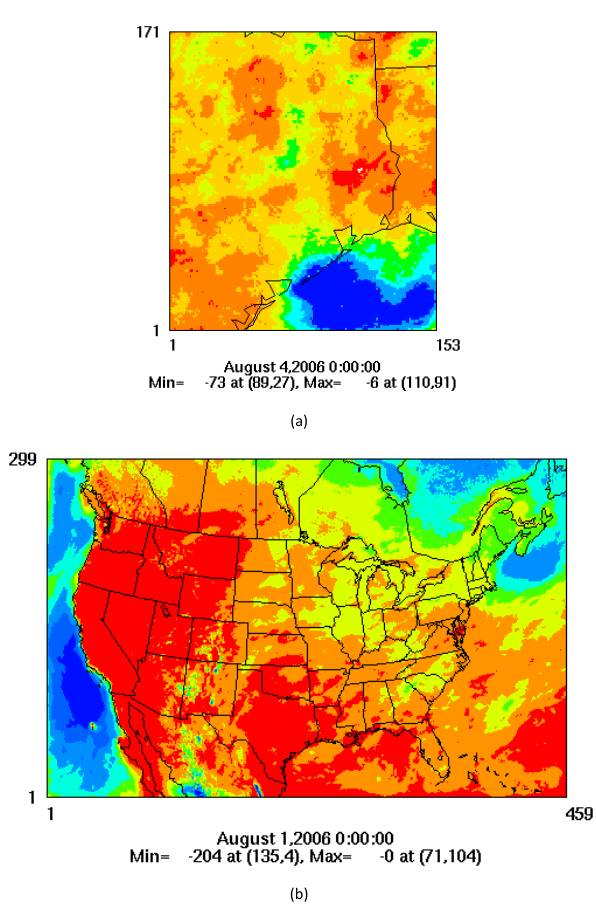
Figure 1. The model domains of WRF-CMAQ for (a) a 4-km resolution model grid over east Texas and (b) a 12-km resolution model grid over the continental US for the monthly mean results of SWCF in August of 2006.